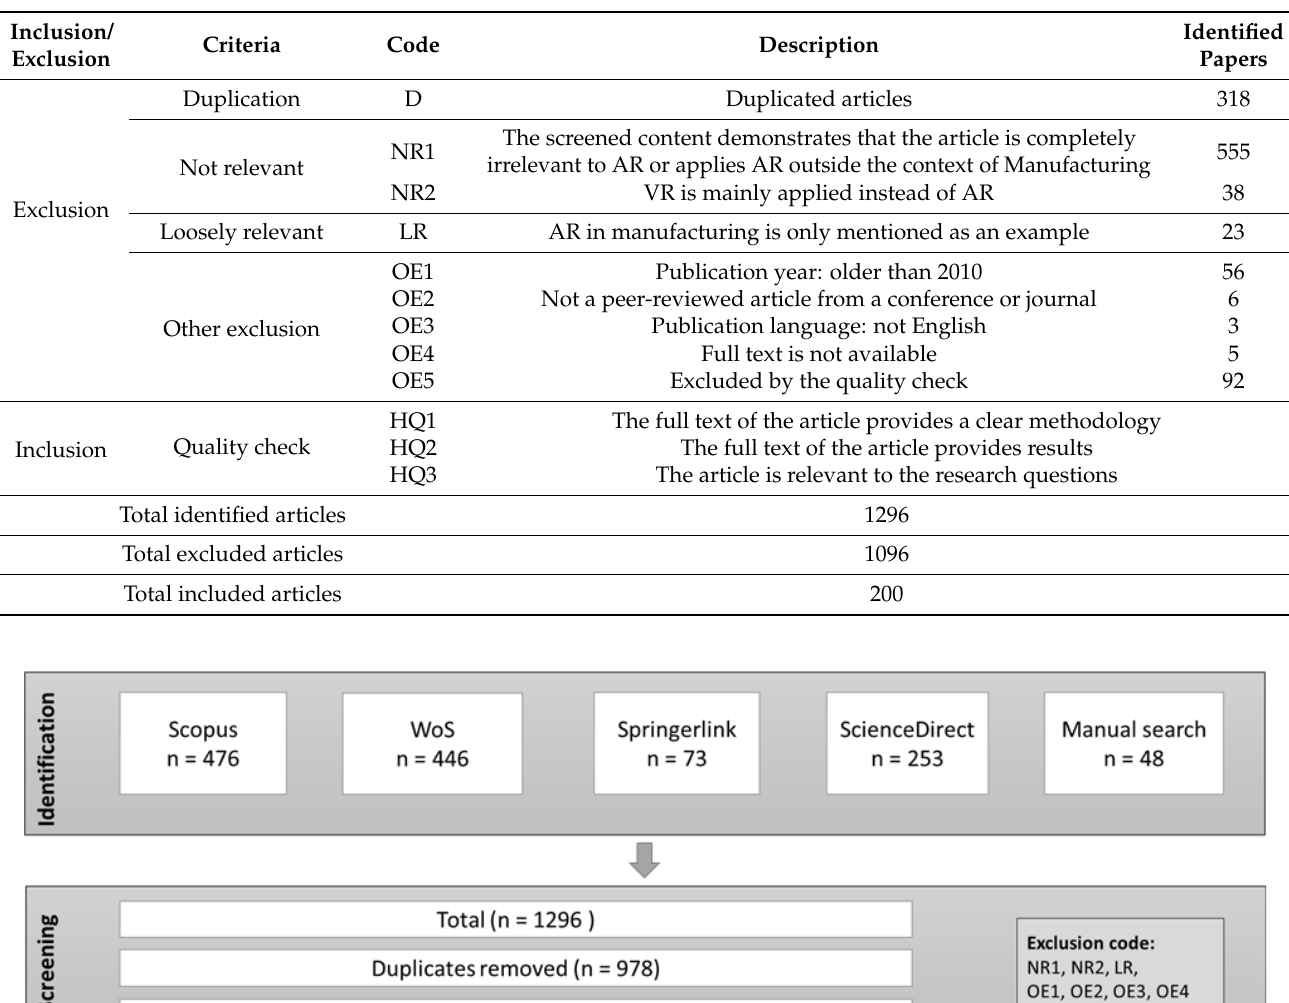
Table 4. Selection criteria.